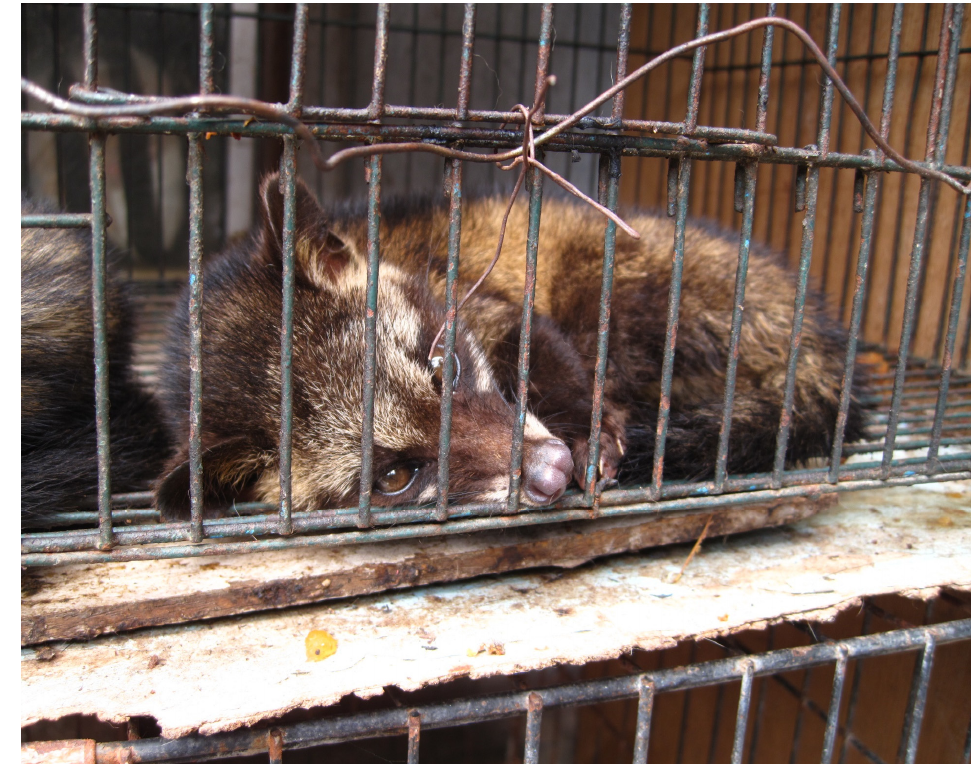
Figure 2. Civet kept caged for Kopi Luwak production (attribution: author Surtr, (https://commons.wikimedia.org/wiki/File:Luwak_(civet_cat)_in_cage.jpg accessed on 8 June 2021) license CC BY-SA 2.0, (https://creativecommons.org/licenses/by-sa/2.0/ accessed on 8 June 2021) via Wikimedia